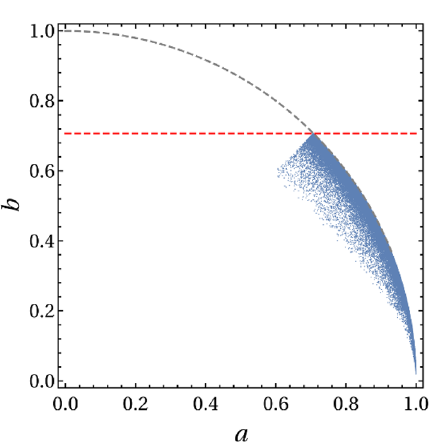
p 2] with b (cid:20) a . The gray dashed line represents p 2.